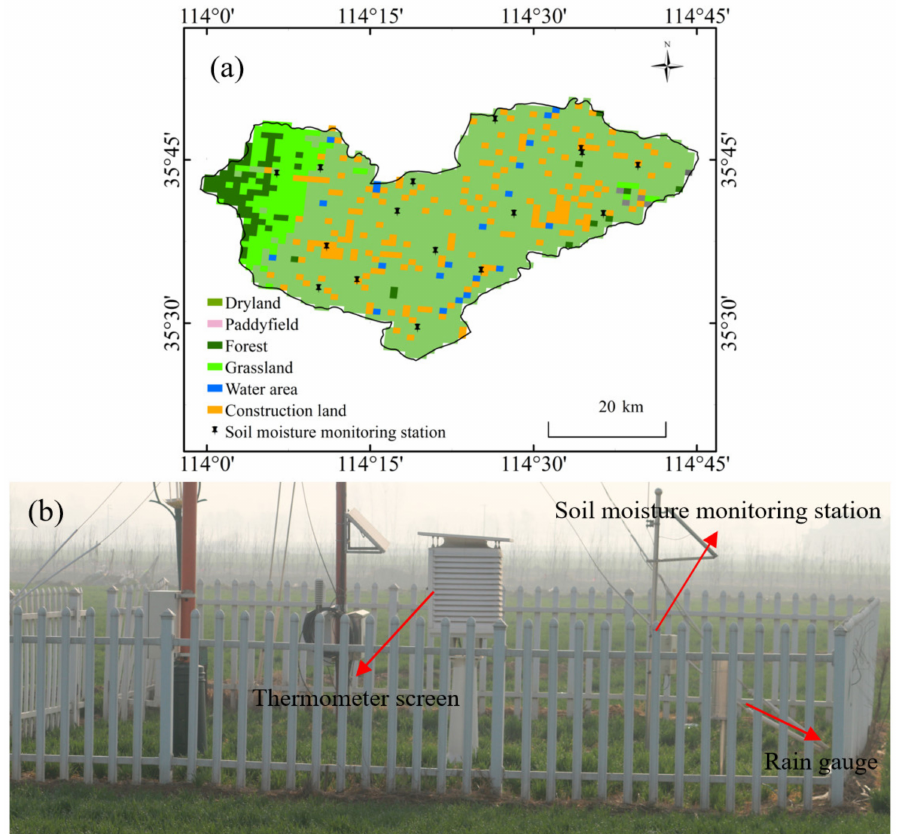
Figure 2. ( a ) Location of In situ soil moisture sites in Hebi City and the land use of Hebi City. ( b ) The environment of each in situ soil moisture